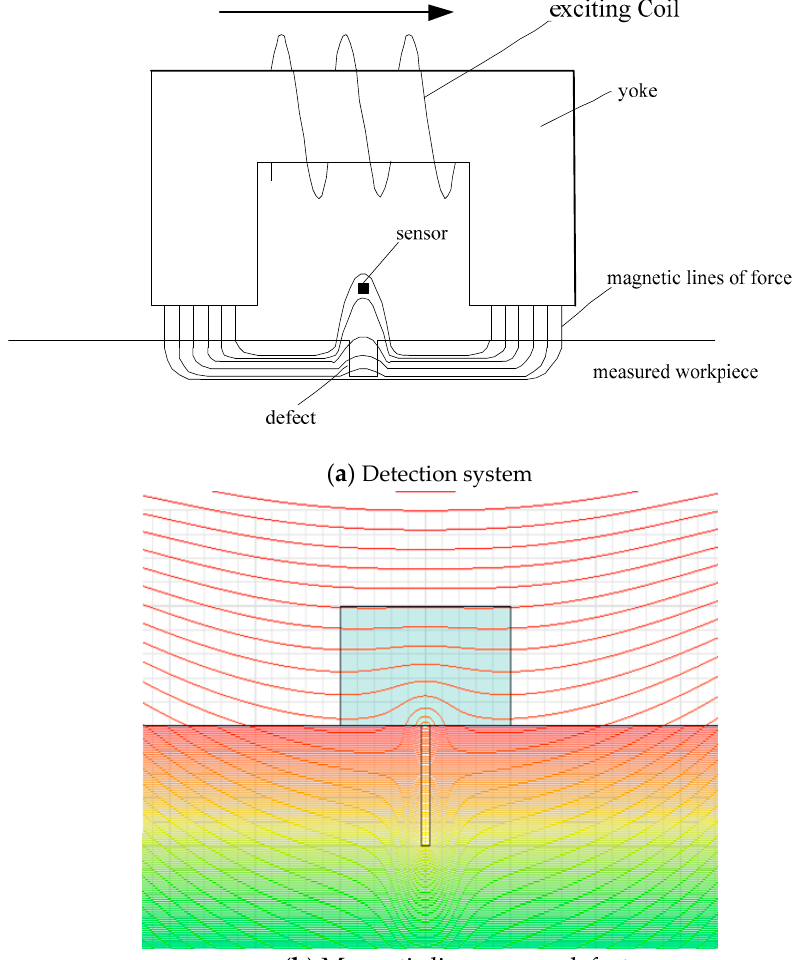
Figure 1. MFL detection.